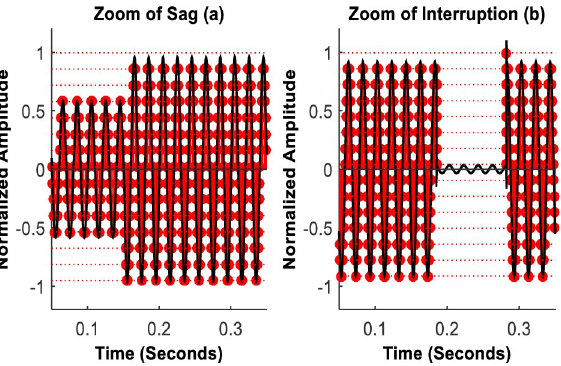
Fig 6. The instances acquired with a 4–bit resolution SPADC for sag (left) and intr.